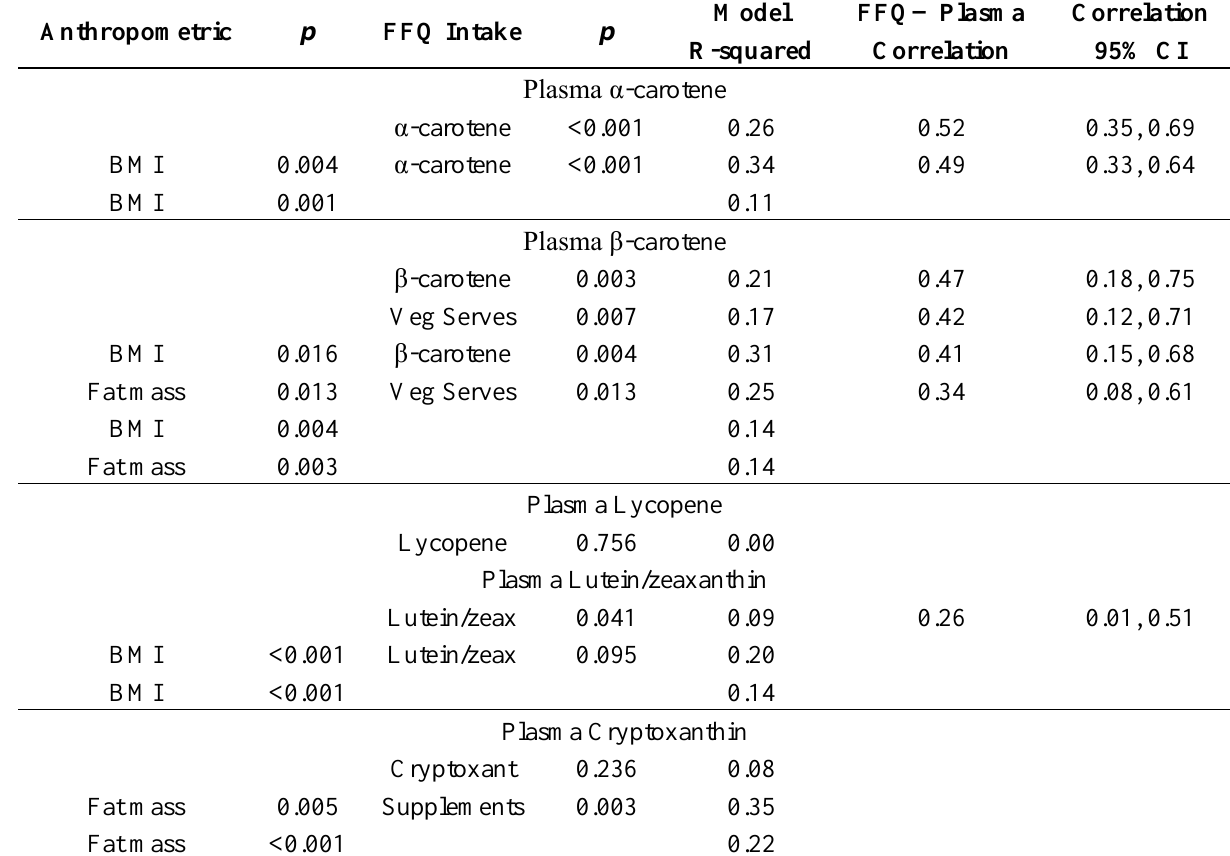
Table 3. Correlations between Food Frequency Questionnaire carotenoid intake and plasma carotenoid concentrations from multivariable linear regression modelling of plasma carotenoids, controlling for Body Mass Index and fat mass, significant at the 5%